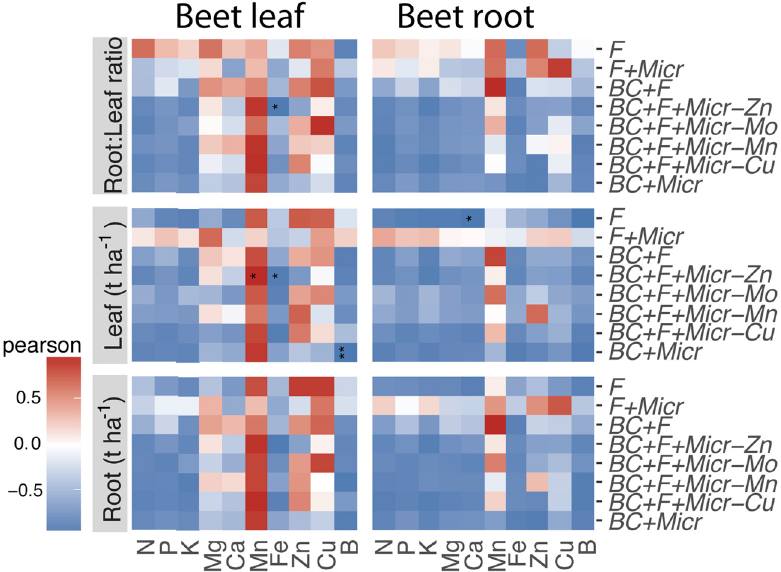
Figure 4: Correlation between biomass production and elemental concentrations in beet leaf or root; the statistically relevant correlations are marked inside the respective box ( signi fi cance codes: 0, “ *** ” ; 0.001, “ ** ” ; 0.01, “ * ” ; 0.05, “ . ” 0.1 ) .